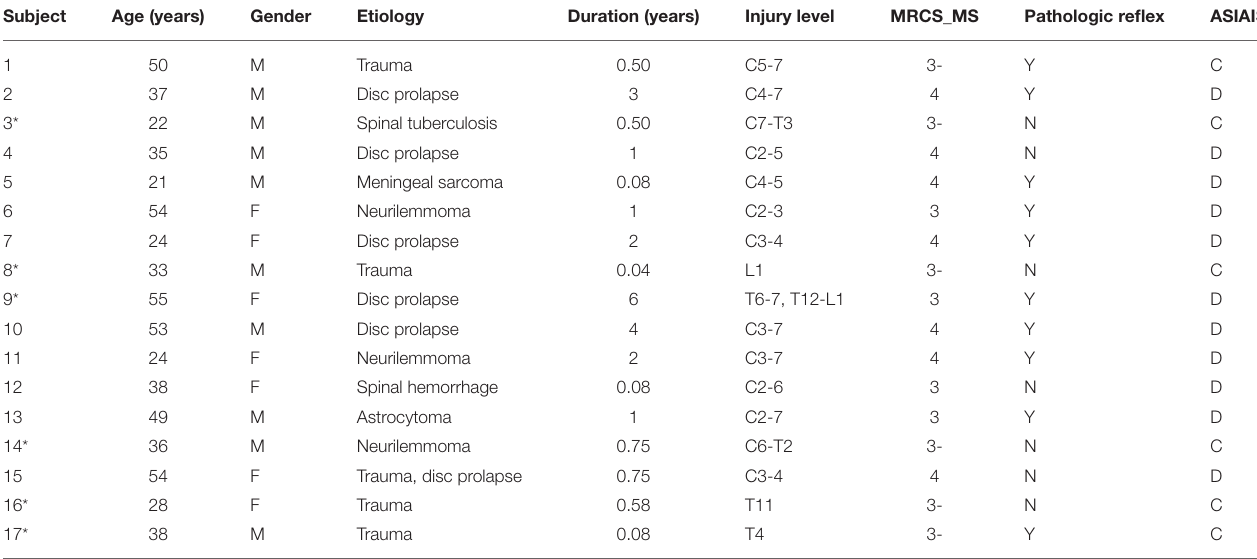
TABLE 1 | Clinical data for patients with